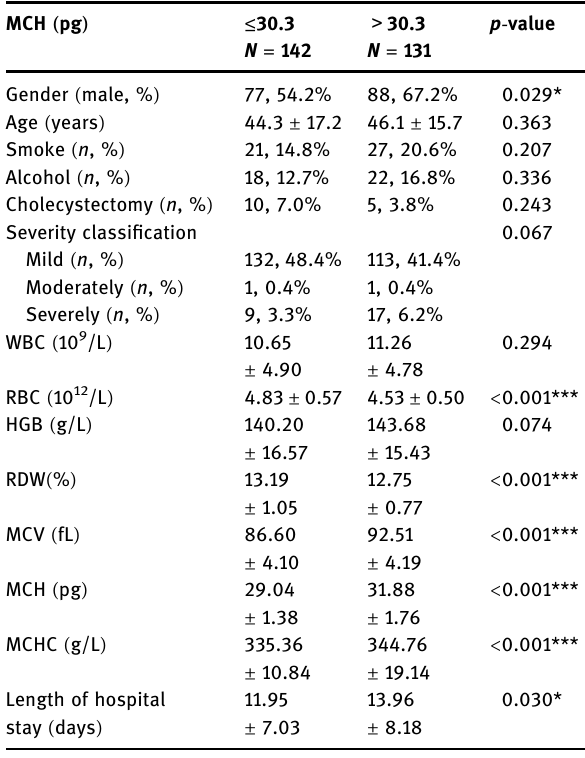
Table 2: The clinical and laboratory data according to MCH